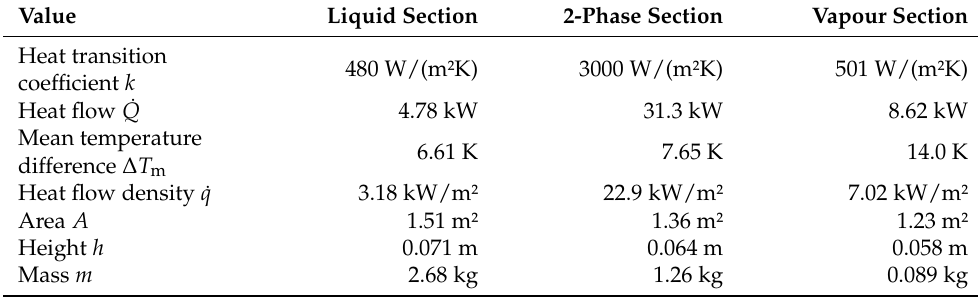
Table A4. Results modelling the ORC